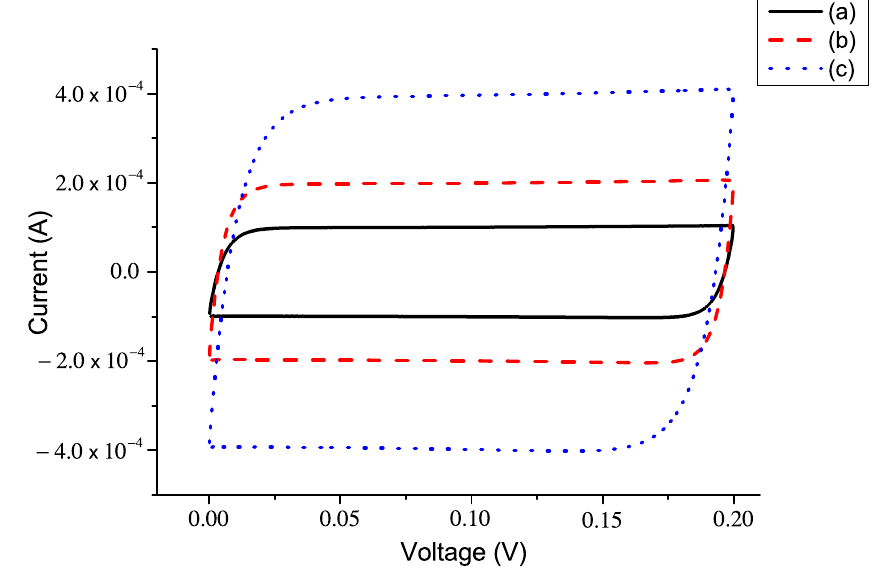
Figure 4. Parametric curves I ( V ) for an electrolytic cell with identical electrodes having the same adsorption properties for positive and negative ions, when the screening parameter is b = 0.04. The curves are drawn for desorption time 1 s, and adsorption coefficient 5 × 10 − 7 m/s (a), 10 − 6 m/s (b), and 2 × 10 − 6 m/s